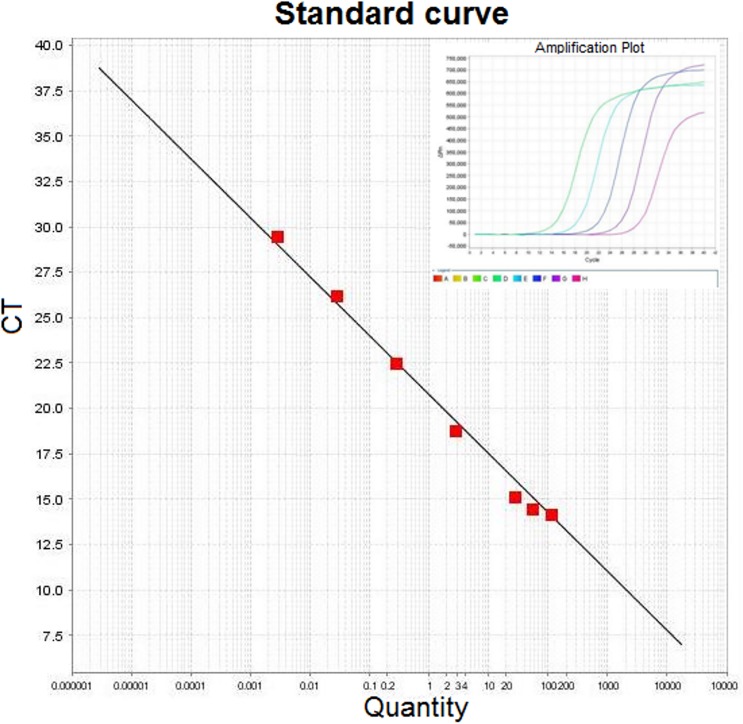
Parasite load (parasites/μg tissue DNA) in tissue biopsy samples were determined by quantitative real-time PCR (Q-PCR) using standard curve with SYBR Green.Extracted DNA from L. donovani were used for standard curve after 10-fold serial dilution. Ct- threshold cycle value; slope- 3.23; intercept- 25.08; R2- 0.991.